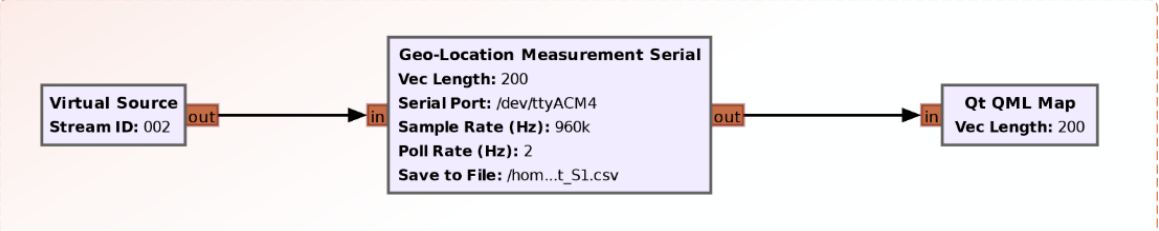
Figure 7. The Geo-Location module.